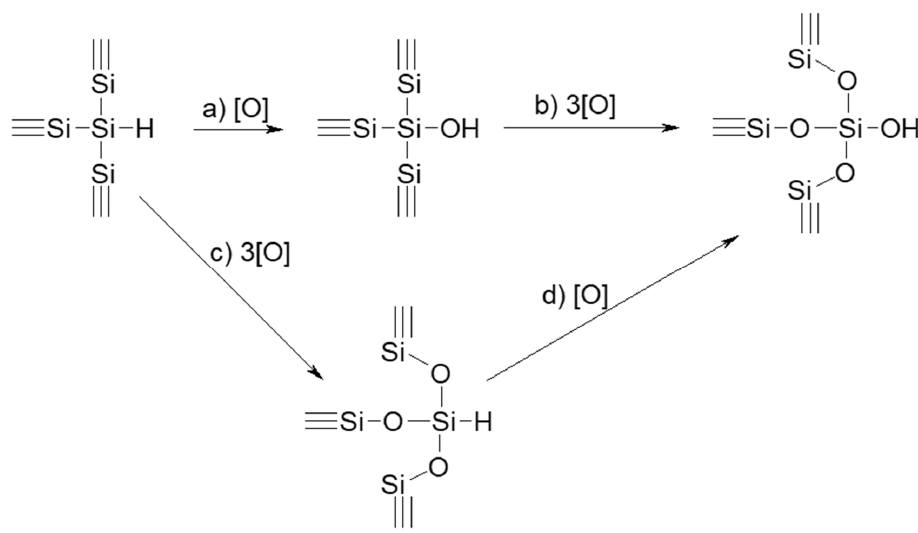
Figure 2. Schematic representation of gradual transformation of initially hydrogenated PSi nanopowder in silicon oxide during its oxidation in